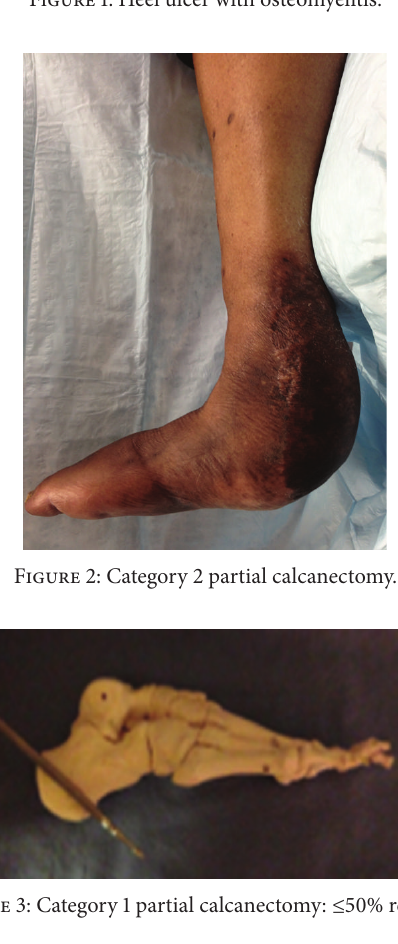
Figure 1: Heel ulcer with osteomyelitis.